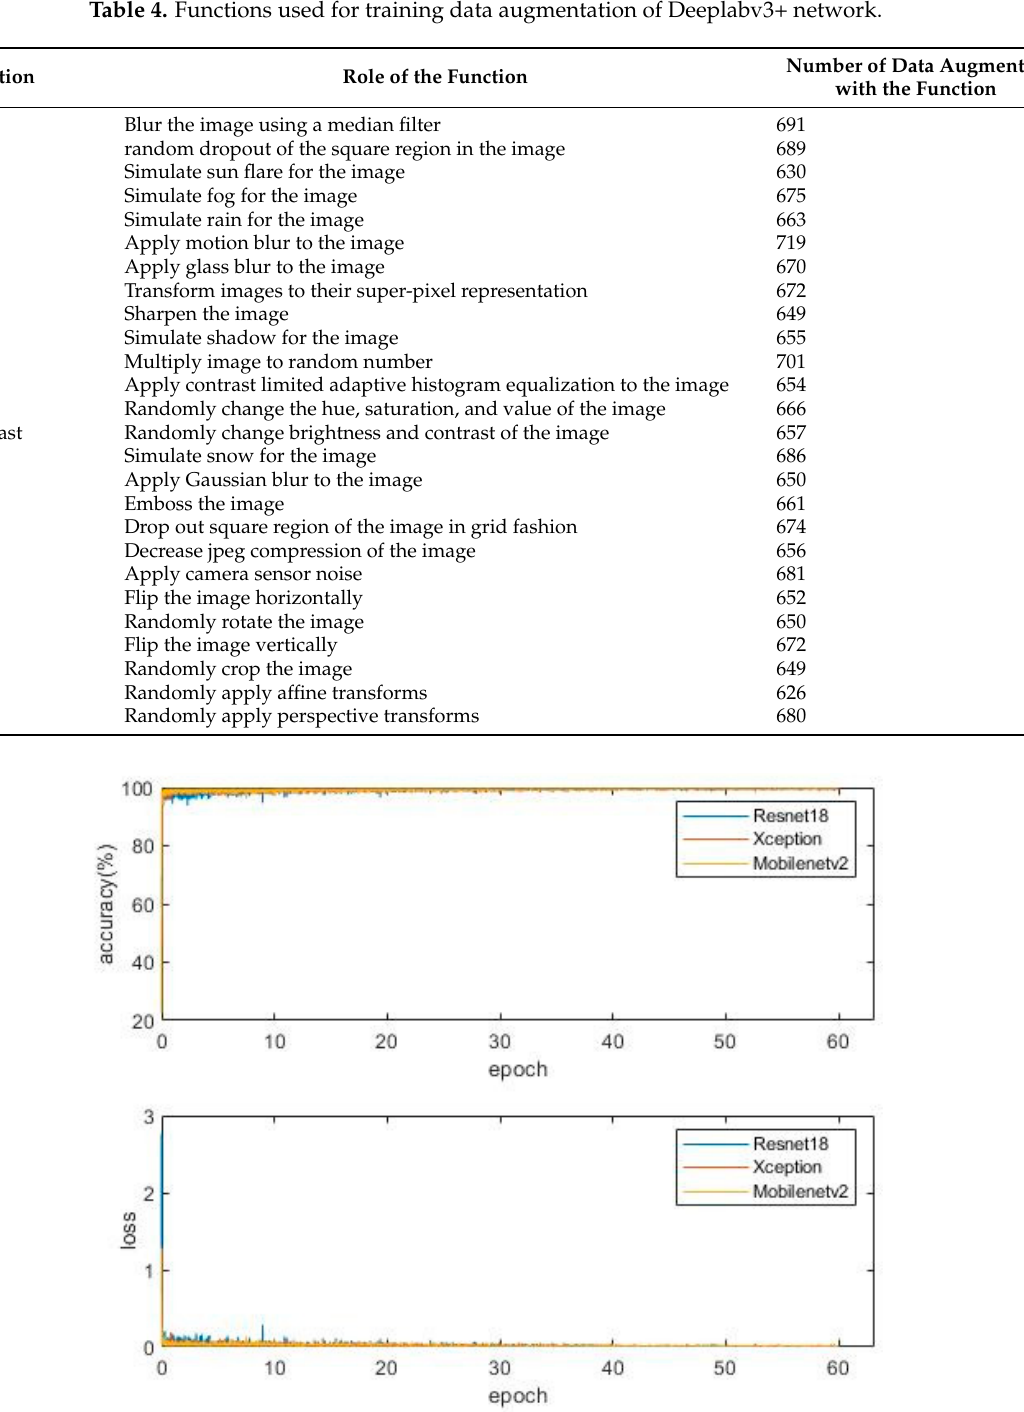
Table 4. Functions used for training data augmentation of Deeplabv3+ network.